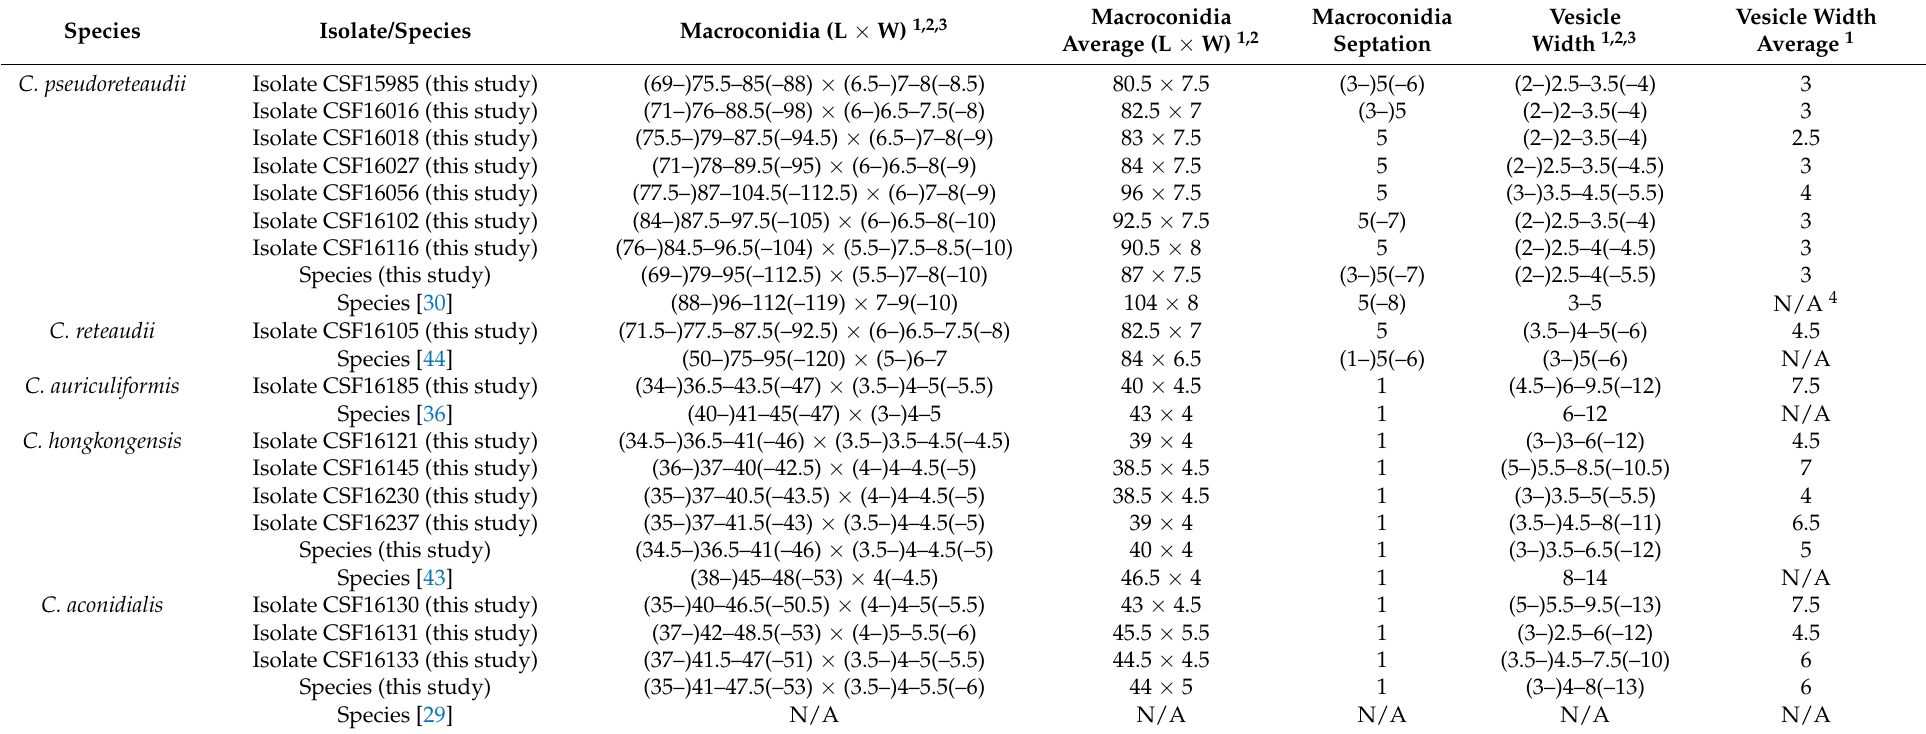
Table 5. Morphological comparisons of Calonectria isolates and species obtained in the current